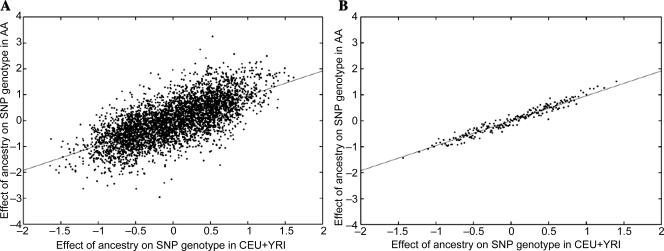
Genetic differences between CEU and YRI are validated in AA samples.Plots are analogous to Figure 2 except that genetic (SNP) data were used instead of gene expression data. (A) We plot a random subset of 4,197 markers, for visual comparison to Figure 2. (B) We average into bins of 20 markers. The slope of each plot is our estimate 0.96 of the parameter c.